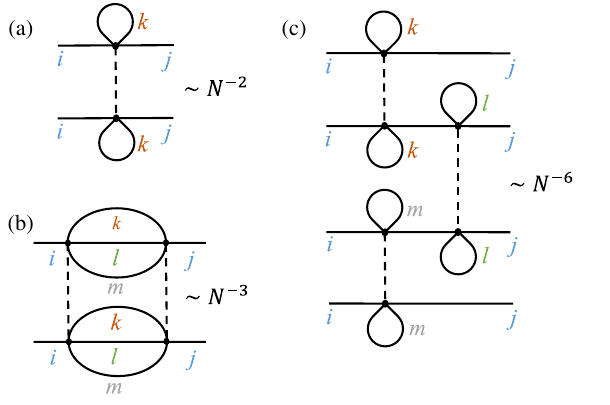
FIG. 10. Low-order contributions to the second and fourth cumulants C 2 , C 4 of the ð i; j Þ element of the single-particle Green ’ s function. (a) O ð N − 2 Þ contribution (lowest order) to C 2 ; (b) O ð N − 3 Þ contribution to C 2 ; (c) lowest-order contribution to C 4 , of order N − 6